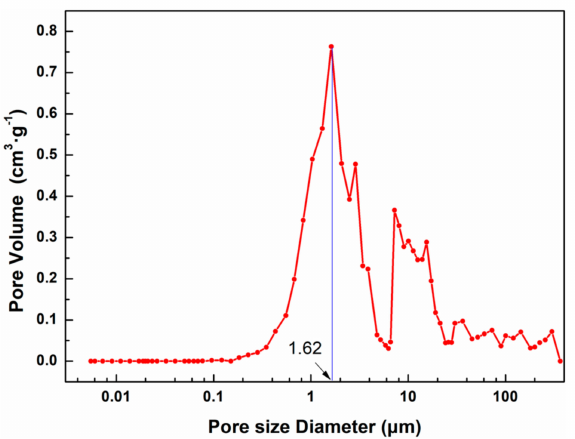
Figure 8. Macropore size distribution (as shown in the red line) of cellulose aerogels prepared by using NaOH/urea solution as solvent via freeze-drying by mercury intrusion method. The blue line shows the pore size corresponding to the